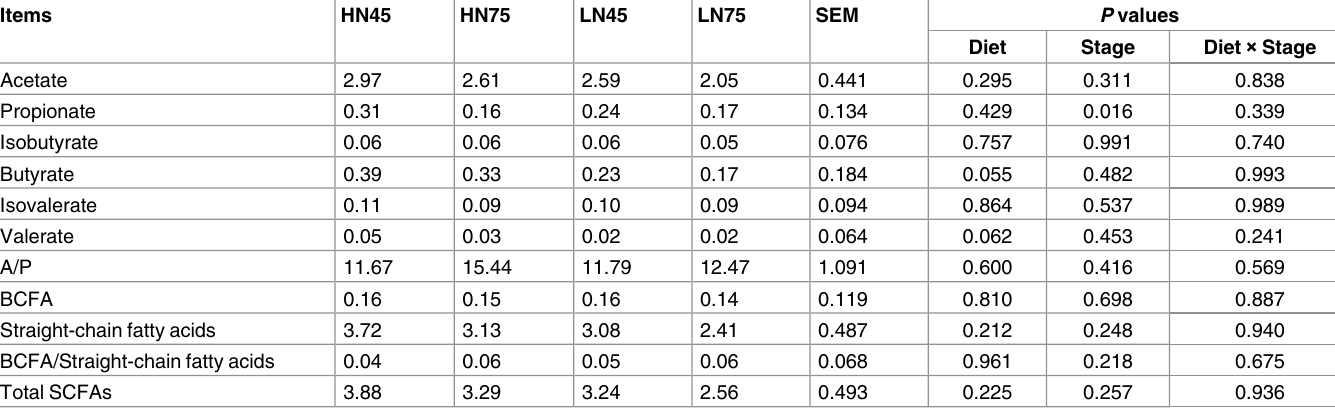
Table 6. Effect of diet and pregnancy stage on ileal SCFA and BCFA concentrations (mg/g) in Huanjiang mini-pigs.